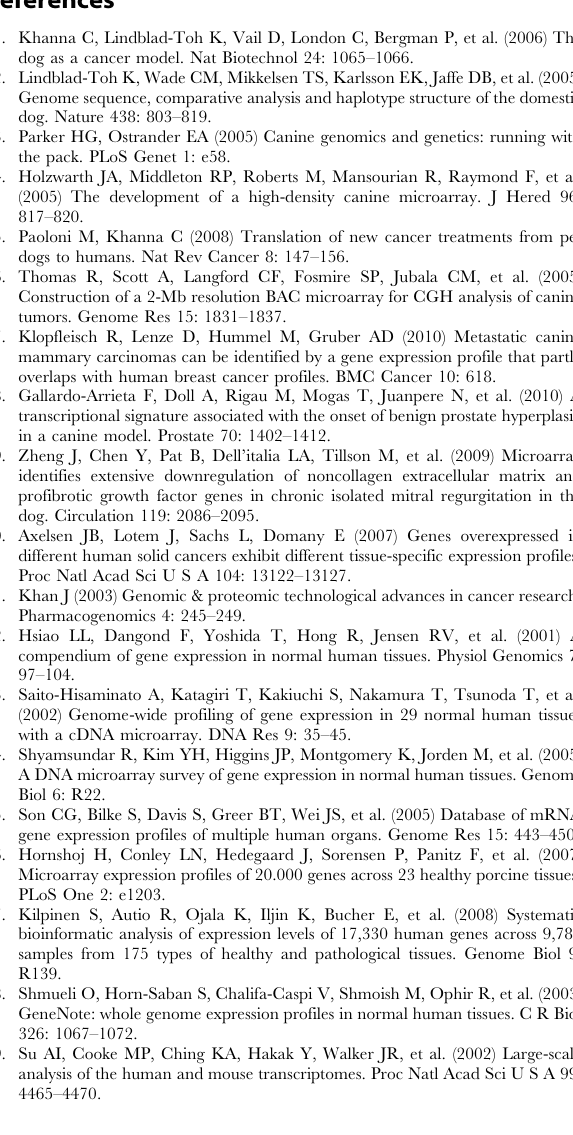
Table S2 Canine lung selective probesets rank ordered with Fold Change vs. all tissues included. Defines probesets specific to the canine lung, and is an example of tissue selective ranking of probesets conducted for each of the ten canine organs examined in this dataset. Table S3 Canine Brain Selective Probesets Over Rep- resented GO Terms. Defines over-represented GO terms in the canine brain, and is an example of the process used to define GO terms for each of the ten canine organs examined in this